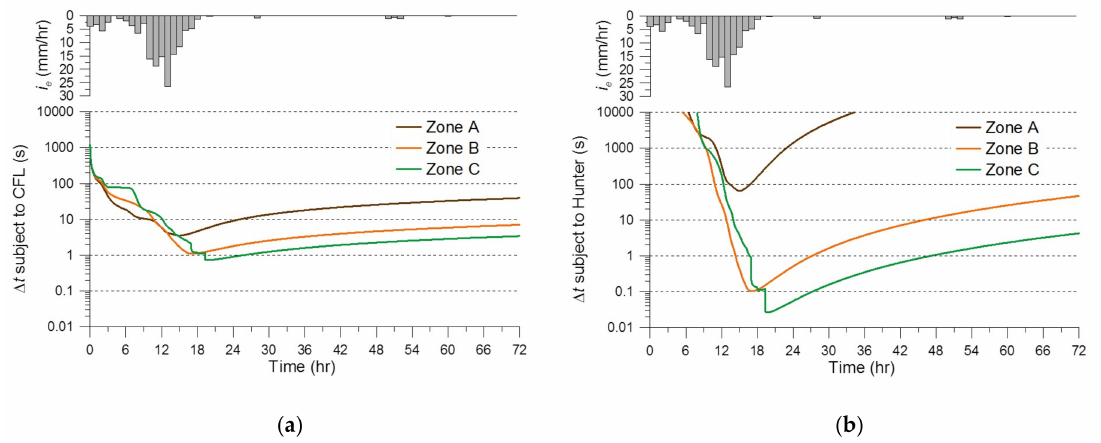
Figure 10. Temporal variations of the allowable time steps within different zones during the simulation of the storm occurring on 16 August 1968, ( a ) CFL criterion; ( b ) CFL